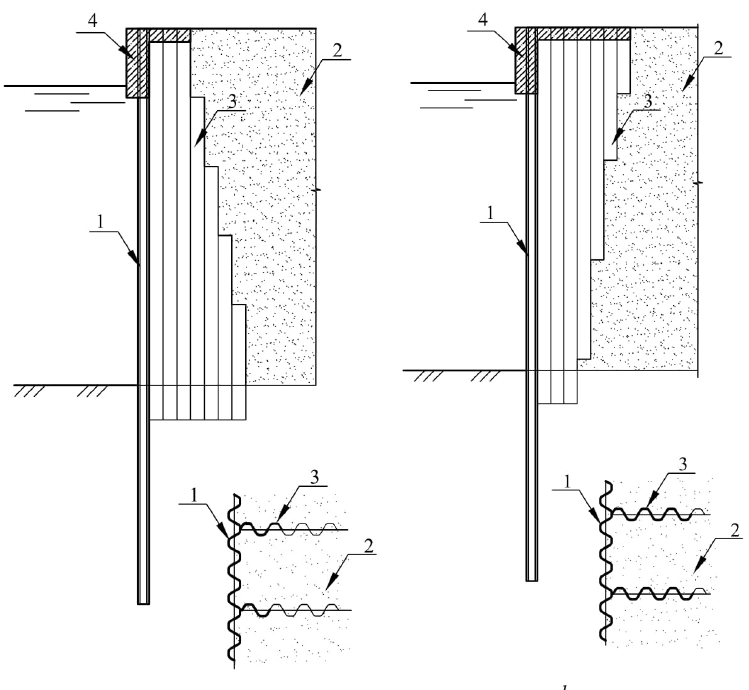
Fig. 2. Tongue-and-groove wall with buttresses: a – trapezoidal shape with extension downwards; b – trapezoidal shape with an extension upwards; 1 – front tongue-and-groove wall, 2 – backfilling, 3 – transverse rows of